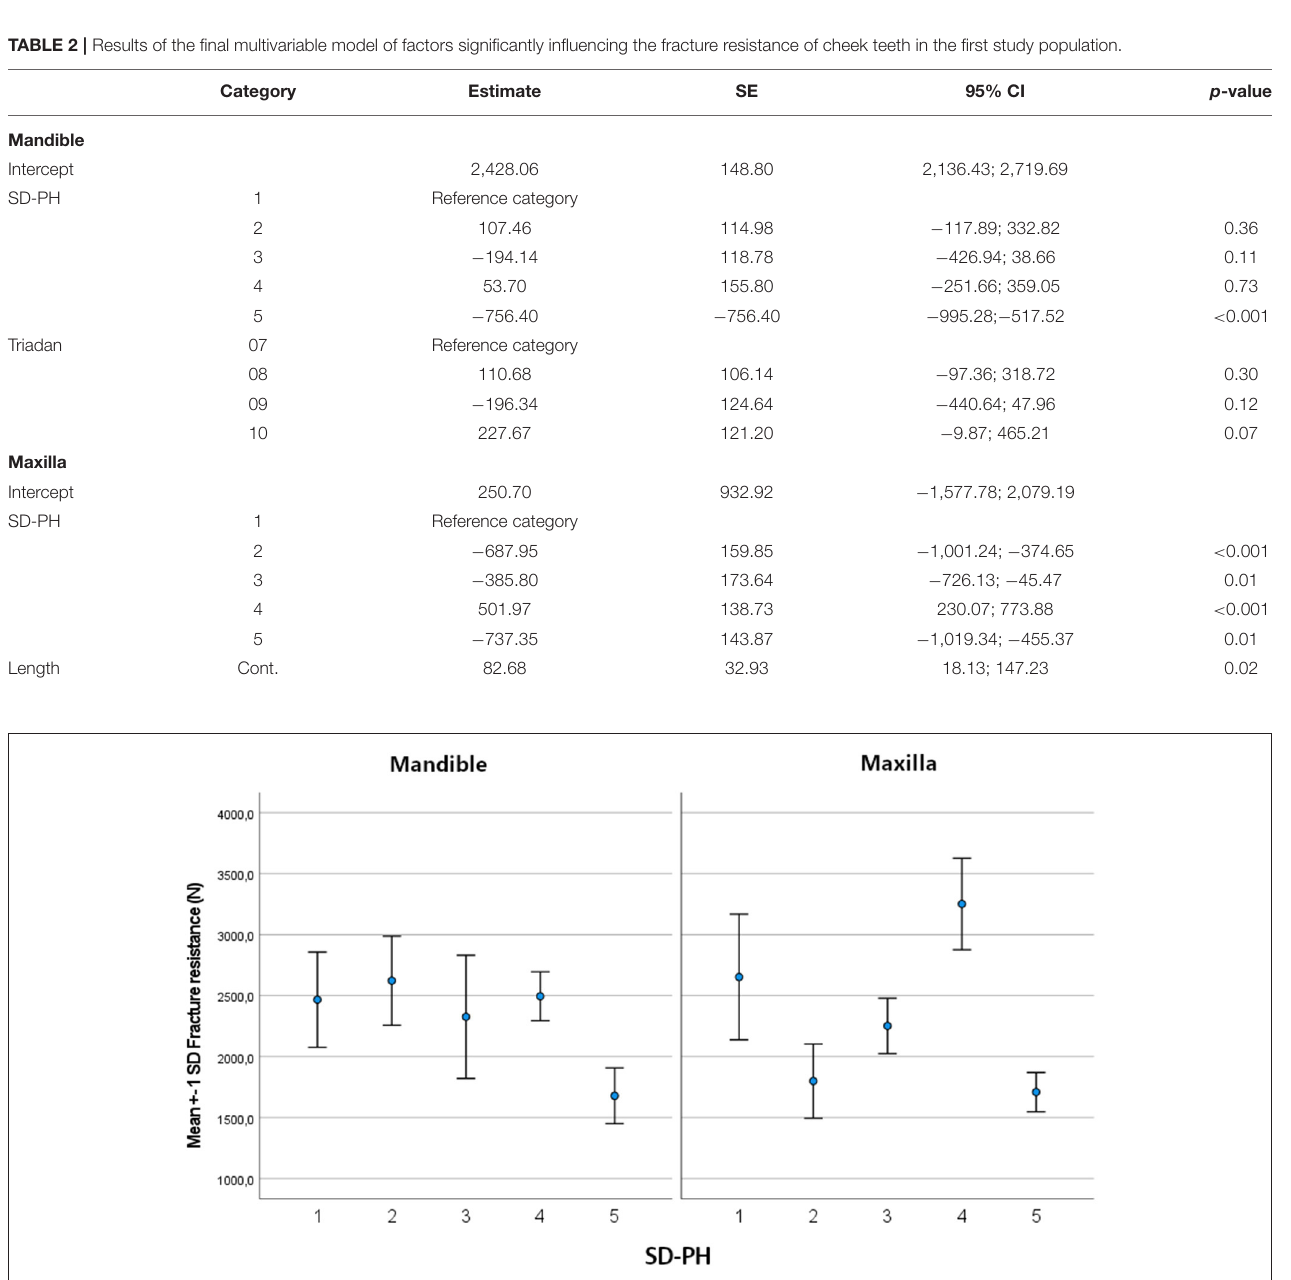
FIGURE 4 | Bar chart illustrating the mean and SD of the fracture resistance in mandibular and maxillary cheek teeth at different locations on the